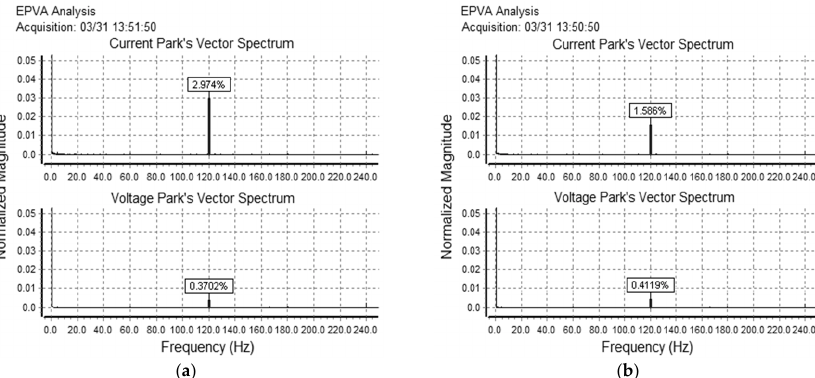
( b ) Figure 7. Trend of rotation frequency pattern of voltage (lower curve) and current (upper curve) signatures for GUs at Goiandira power plant: ( a ) GU#1; ( b ) GU#2. In order to verify if the data sets of rotation frequency of current signature of GUs were statistically different and reinforce the ESA diagnosis effectiveness, a two-sample t-test has been performed [43] using Minitab software. The data used for the hypothesis testing were the rotation frequency component’s magnitudes in dB of current signals in the period of analysis. Table 2 presents the results for the two-sample t-test for the fault pattern in question. Table 2. Results of two-sample t-test for rotation frequency of current signature . GU Number of Samples